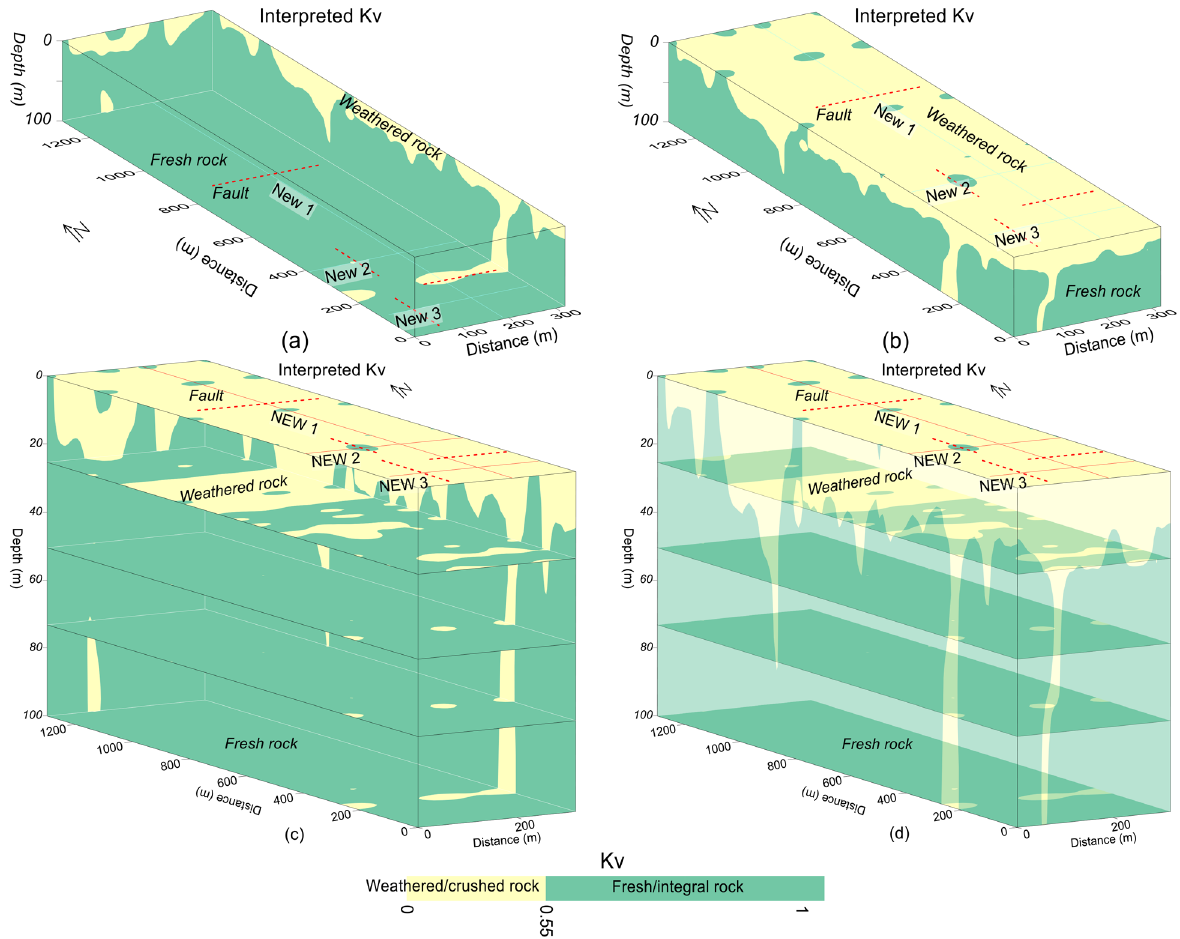
Figure 12. Kv imaging along three profiles (red lines) interpreted by the crushed/weathered rock (yellow color), the integral/fresh rock (green color) and the faults (dashed red lines) for: ( a ) inner view of 3D Kv, ( b ) outer view of 3D Kv, ( c ) different depths including 3D Kv (inner view), ( d ) the outer view of 3D Kv with different depths.